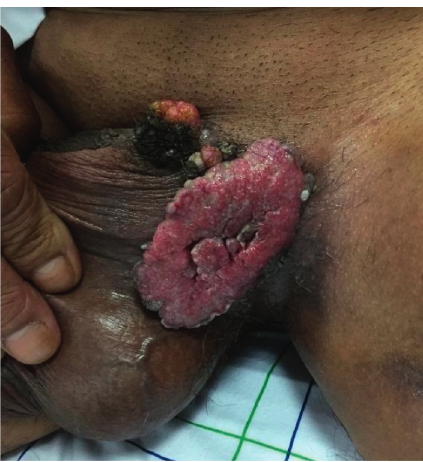
Figure 1: Inguinoscrotal exophytic lesion with a warty surface giving a cauliflower appearance.